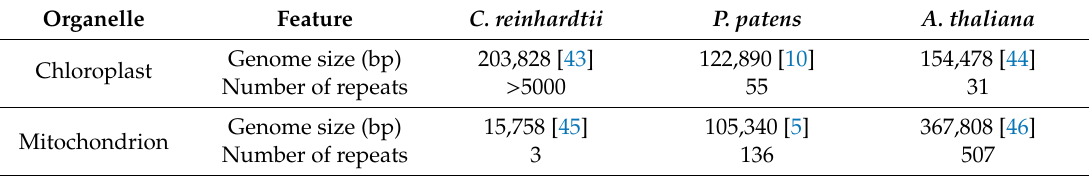
Table 2. Genome size and number of repeats in